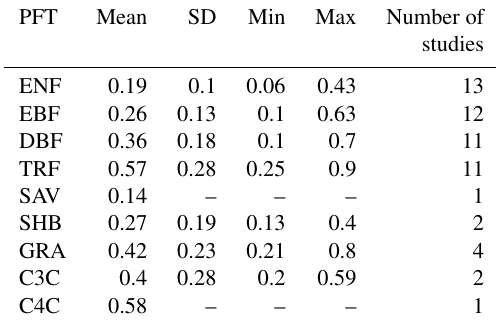
Table 1. Literature summary of decoupling coefficients; see Ta- ble A2 for summaries of individual studies. Plant functional types (PFT) are defined as ENF – evergreen needleleaf forest, EBF – ev- ergreen broadleaved forest, DBF – deciduous broadleaved forest, TRF – tropical rain forest, SAV – savanna, SHB – shrub, GRA – grasses, C3C – C 3 crops, and C4C – C 4